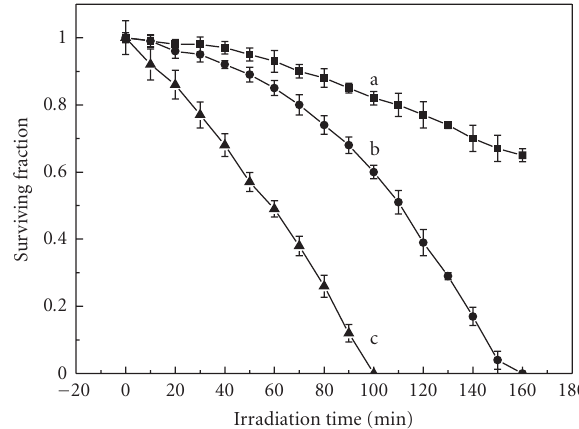
Figure 4: Surviving fraction of LoVo cells incubated in the medium containing 50 μ g/mL Au / TiO 2 nanocomposites with di ff erent Au ratio: (a) 0 wt%, (b) 1 wt%, (c) 2wt%, and (d) 4wt%. The wave- length of UV light is 365 nm, and the intensity is 4.0 mW/cm 2 . Bars represent the region of measured data and the points represent the mean value from three measurements.